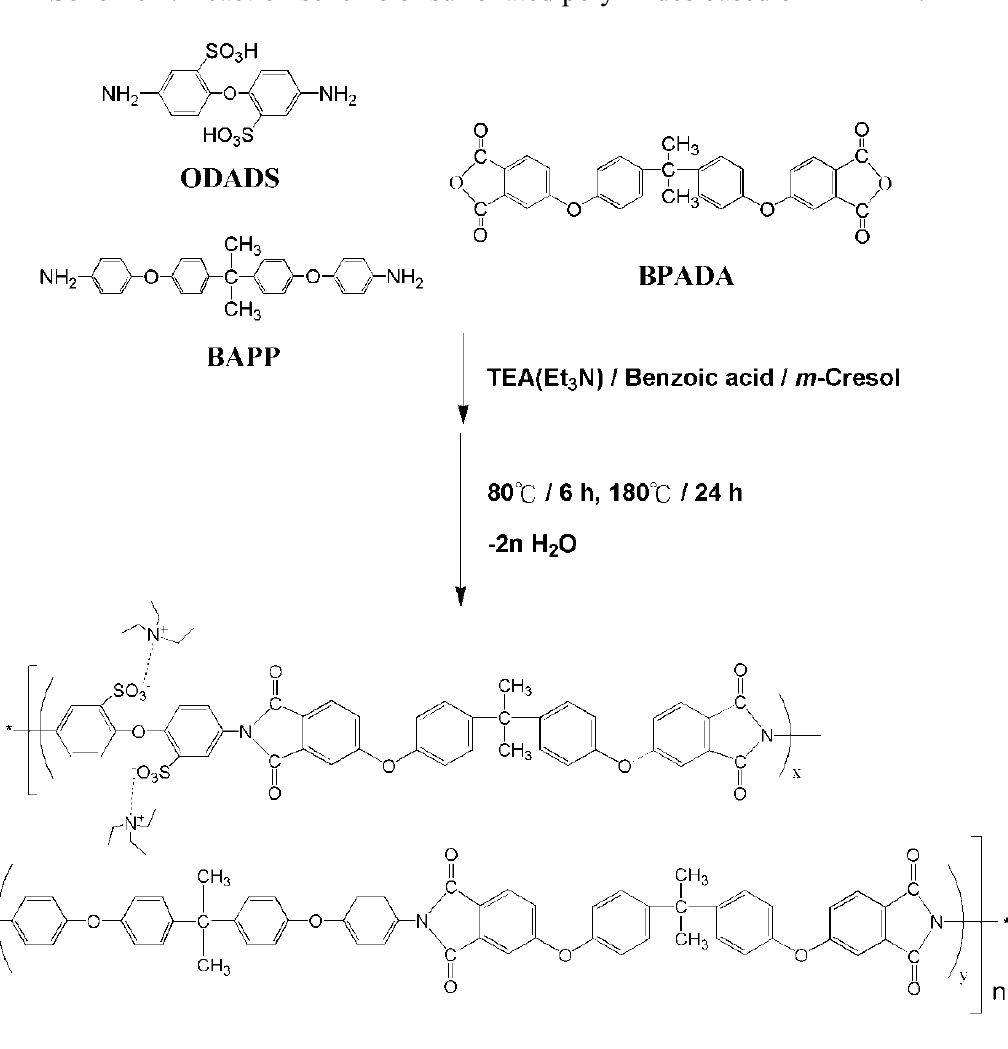
Scheme 1. Reaction scheme of sulfonated polyimides based on